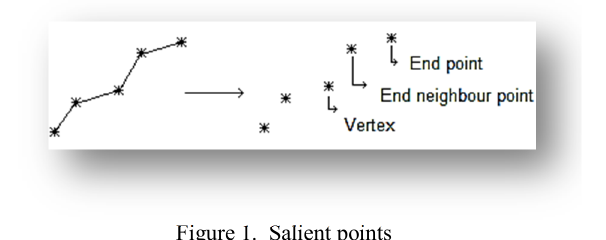
Figure 1. Salient points Link hypothesis: the possibility of gap occurrence between tow end points is link hypothesis and it could be true or false. Short gaps: the gaps that their lengths are shorter than the width of the road are called short